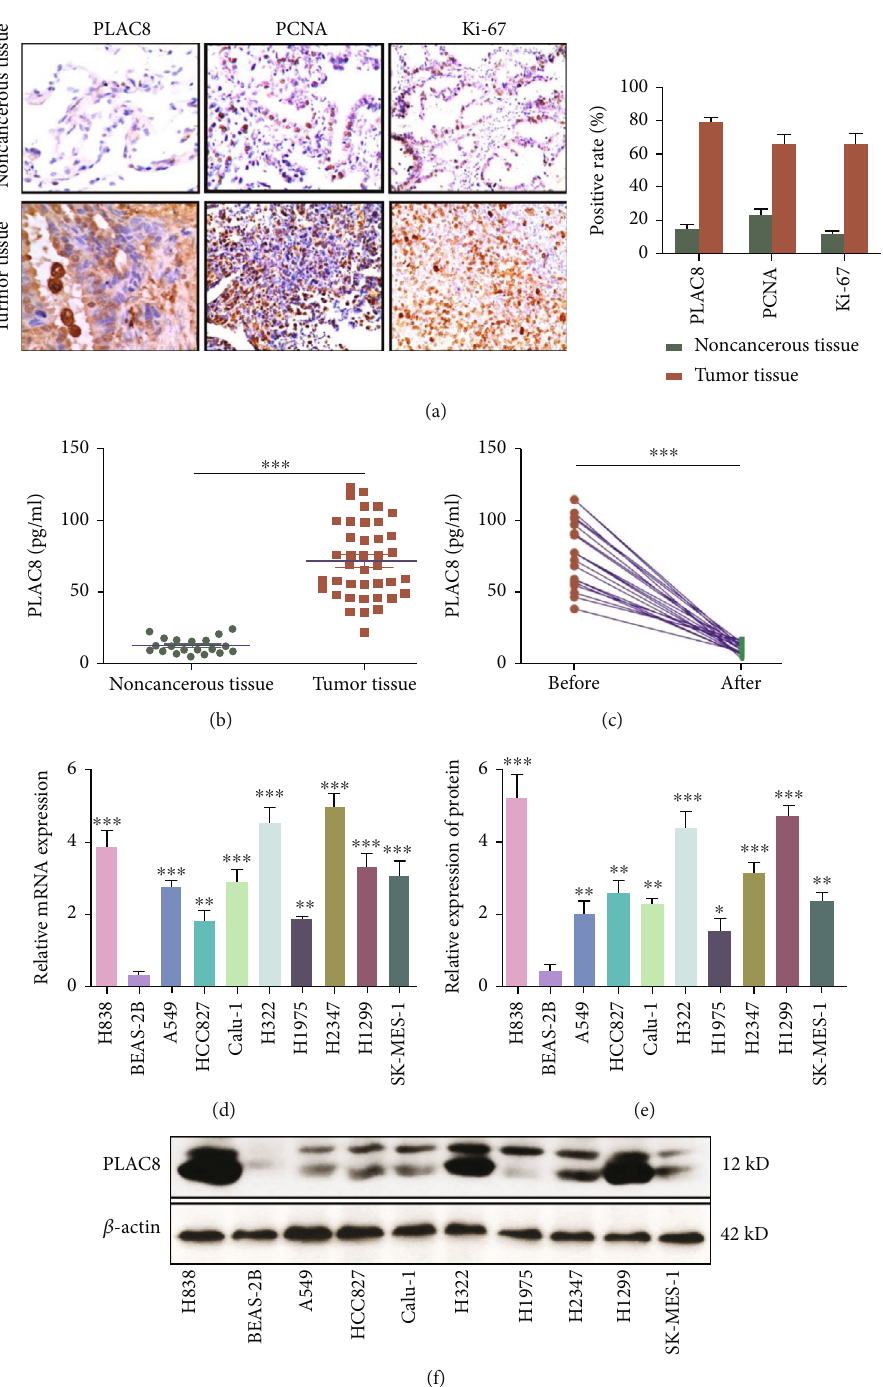
Figure 1: PLAC8 expression level in lung cancer patients and lung cancer cell lines. (a) PLAC8 expression level in lung cancer tissues and nontumor tissues (left: immunohistochemistry; right: statistical analysis). (b) PLAC8 expression level in serum of lung cancer patients and healthy people. (c) Expression of PLAC8 in serum of patients with lung cancer before and after operation. (d) PLAC8 mRNA expression level in lung cancer cell lines. (e, f) PLAC8 protein expression in lung cancer cell lines, ∗ p < 0 : 05 ; ∗∗ p < 0 : 01 ; ∗∗∗ p < 0 : 001 . All these cell biological function assays were